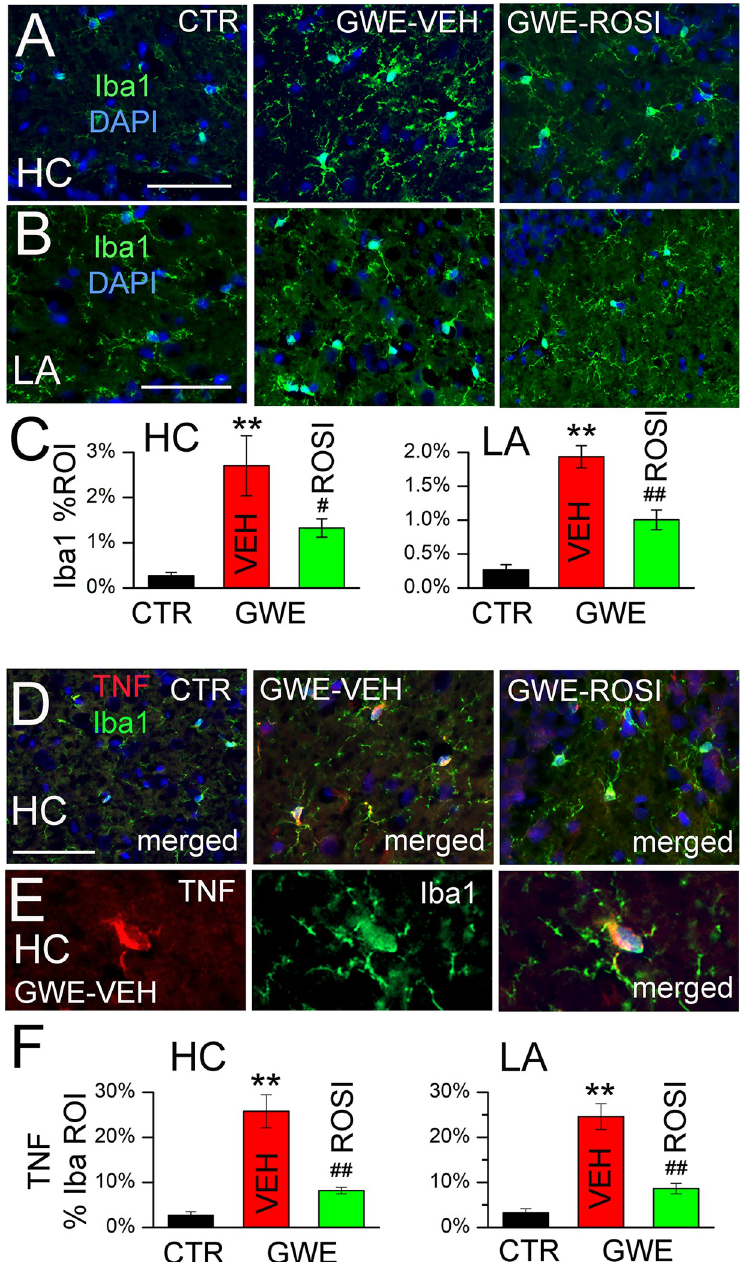
Fig 6. Microglial activation following 33-day GWE. A,B: Immunolabeling for Iba1 in hippocampus (HC) and lateral amygdala (LA) in na ï ve (CTR), GWE-VEH and GWE-ROSI rats; nuclear staining with DAPI (blue) is also shown; bars , 100 μ m. C: Quantification of Iba1 in the two brain regions for the three groups, as indicated; 5 rats per group; �� , P < 0.01, compared to na ï ve; #, P < 0.05 and ##, P < 0.01, compared to GWE-VEH. D: Co-immunolabeling for Iba1 and TNF in hippocampus in na ï ve (CTR), GWE-VEH and GWE-ROSI rats; nuclear staining with DAPI (blue) is also shown. E: High magnification image of a cell co-immunolabeled for Iba1 and TNF, showing TNF within the Iba1-positive cell. F: Quantification of TNF within the Iba1-defined ROI in the two brain regions (HC and LA) for the three groups, as indicated; 5 rats per